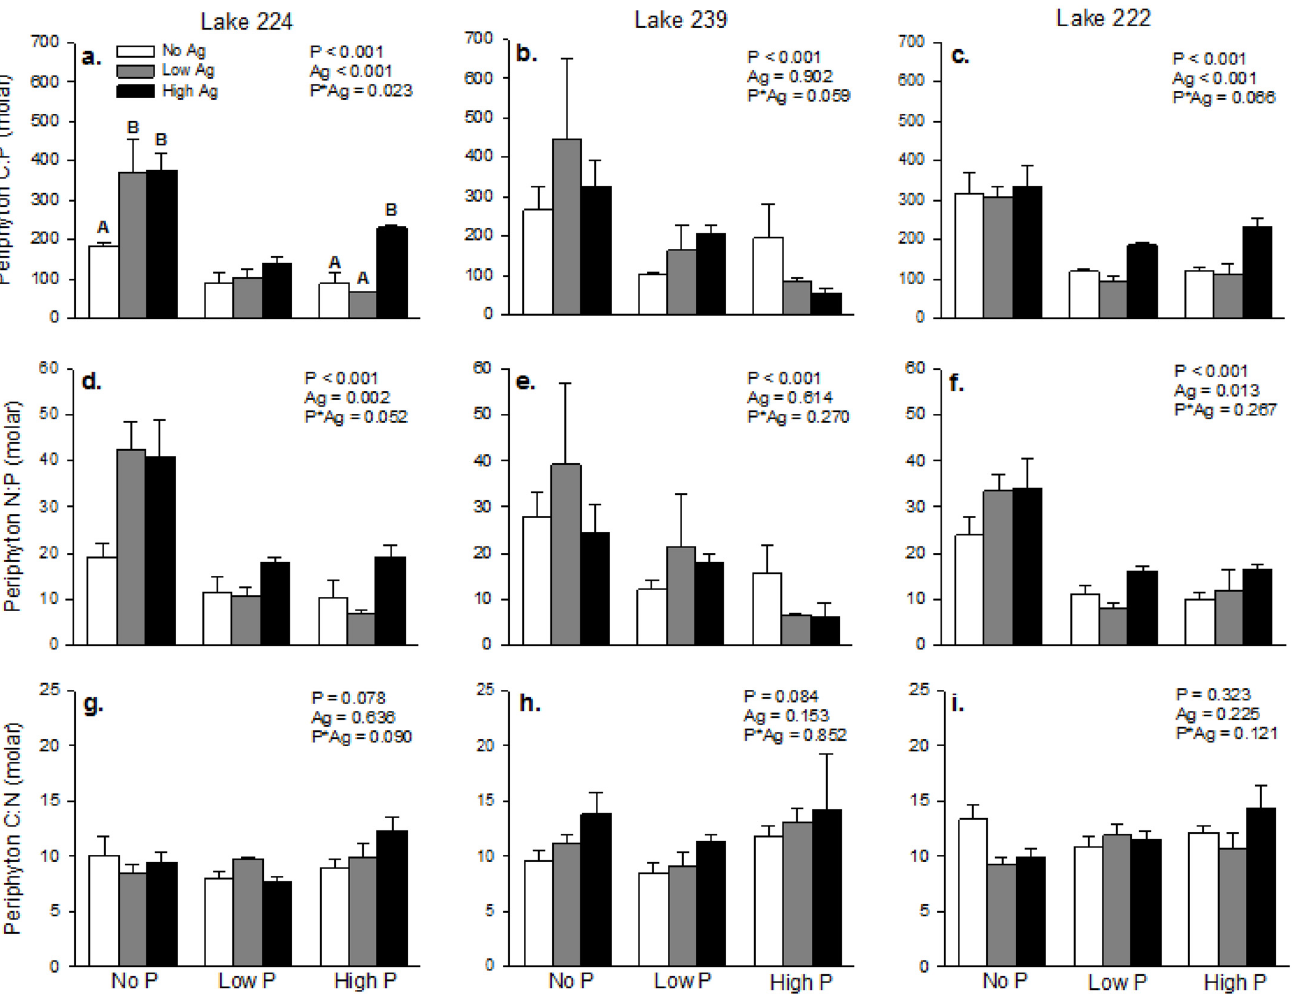
Fig 3. Periphyton stoichiometry from all three lakes. Bars are means of three substrates with standard deviation whiskers. P values for main and interactive effects (2-way ANOVA) are presented in each panel. For variables with a significant P * Ag interaction, different capital letters indicate significantly different means among AgNP treatments within the same P treatment as determined by Tukey pairwise